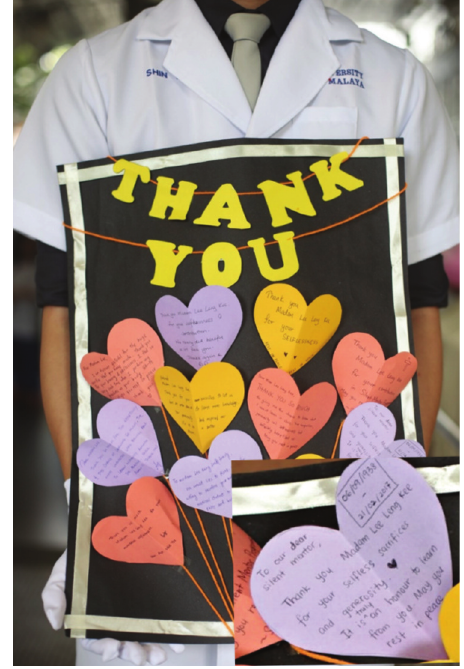
Souvenirs from medical students dedicated to the Fig. 3: mentors on the sending off ceremony.